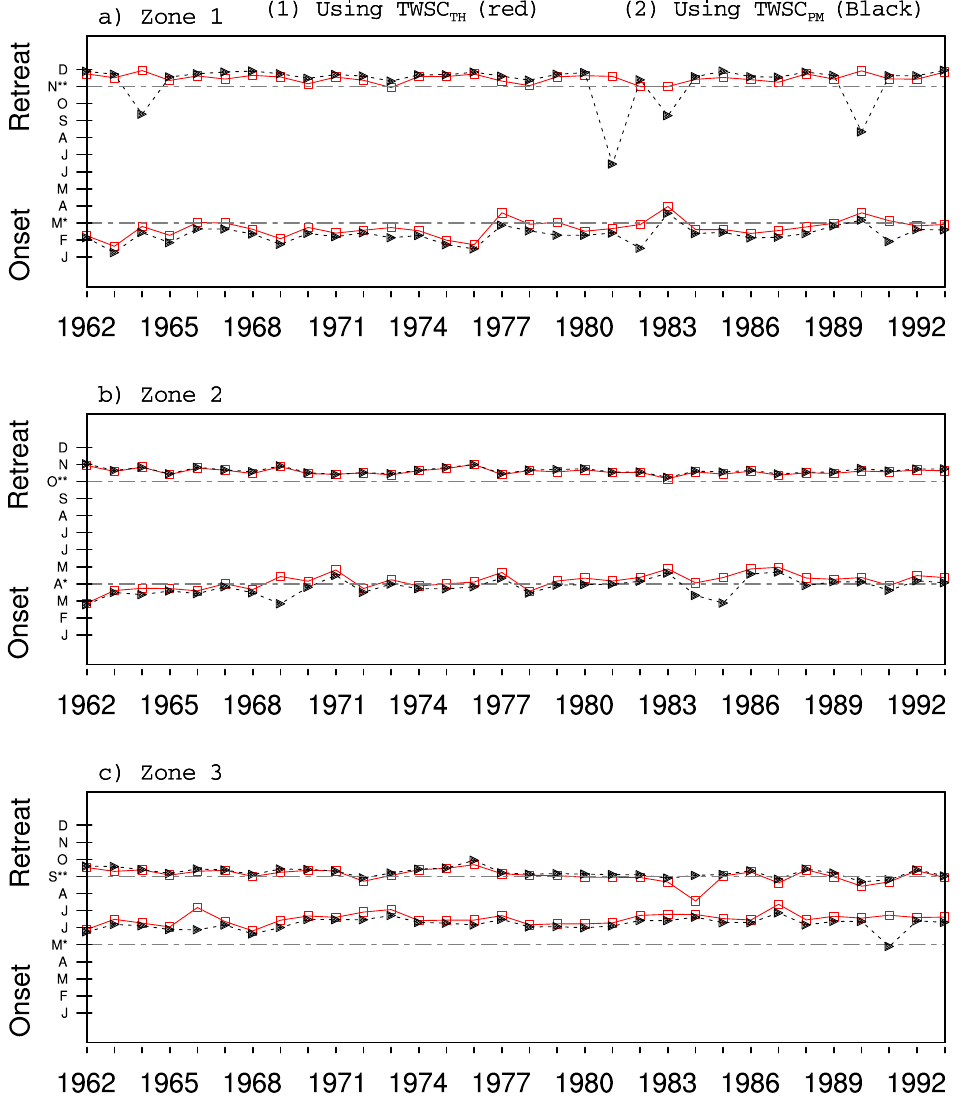
Figure 6. Onset and retreat dates of the rainy season for an individual year and using the TWSC method. TWSC TH and TWSC PM were considered for the three defined zones: ( a ) for the Equatorial forest zone named Zone 1 (south of study area); ( b ) for the transition zone between the Equatorial forest zone and the Sahel zone named Zone 2; and ( c ) for the Sahelian zone named Zone 3 (north of study area). The labels on the y-axis (J, F, ..., D) indicate the months of the year (January, February, ..., December) respectively. For each zone, there are two horizontal dashed lines representing the mean onset and retreat month of the rainy season [30] and labeled by one and two stars, respectively. These reference months are absolutes and correspond to those containing onset and retreat dates in terms of pentads and their variabilities (not more than six pentads for the highest